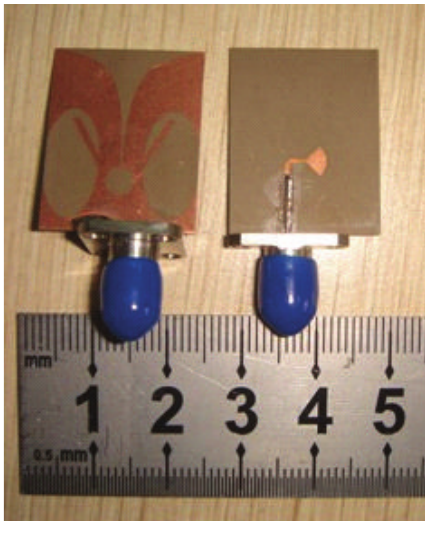
Figure 2: View of the fabricated stealth